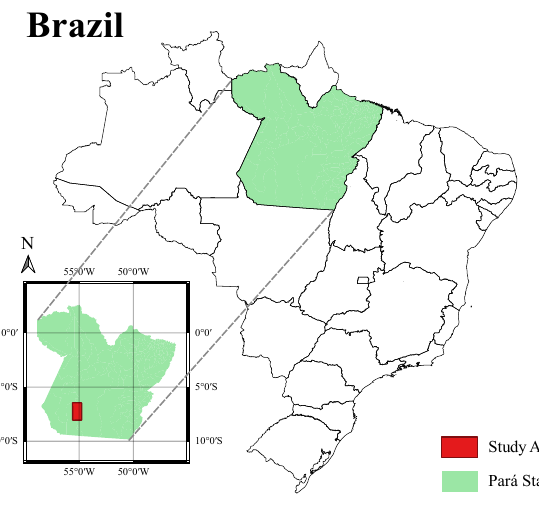
Figure 2. Study area corresponding to a region of the Par´a State,